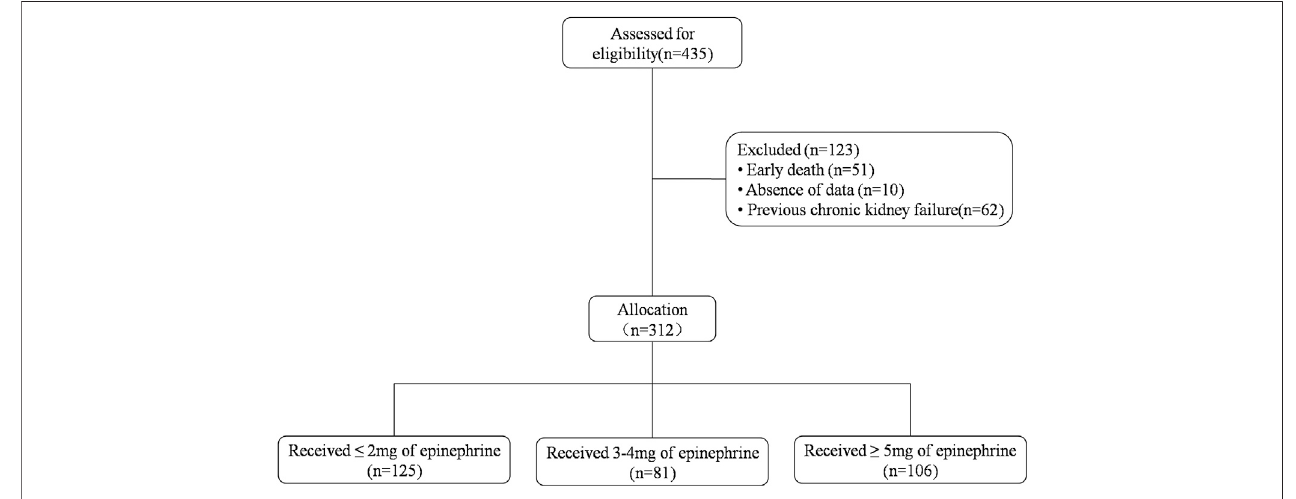
FIGURE 1 | Study participant